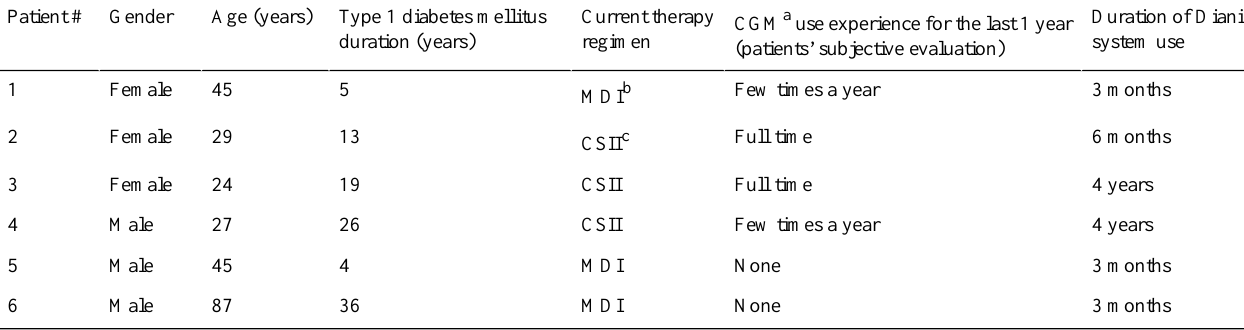
Table 1. Demographic and baseline characteristics.